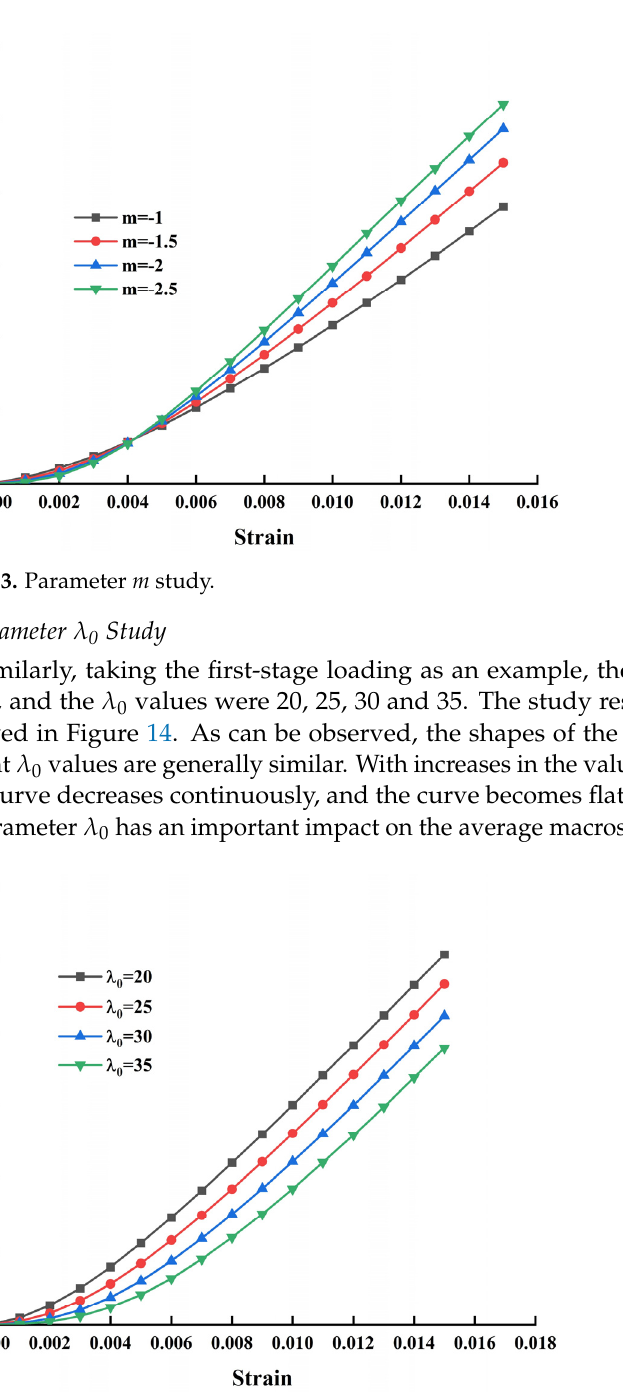
Figure 14. Parameter 0